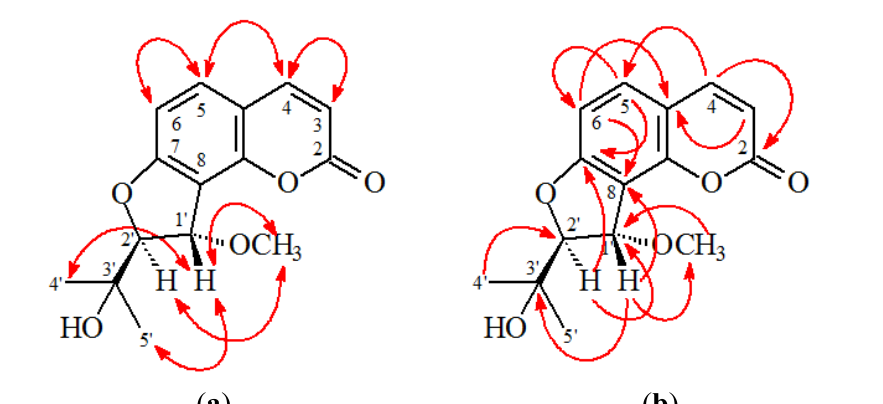
Figure 5. Key NOESY ( a ) and HMBC ( b ) correlations of 3